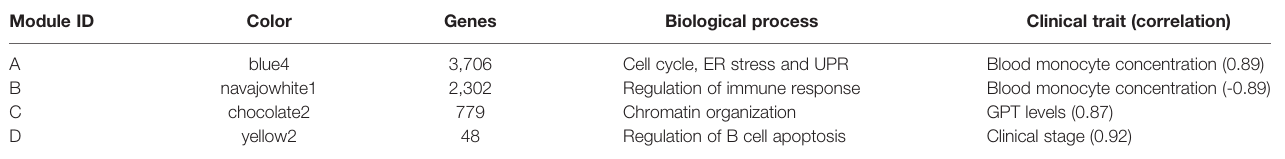
TABLE 2 | Summary information of the key co-expression modules detected in the lymph nodes of dogs suffering from CanL. Module